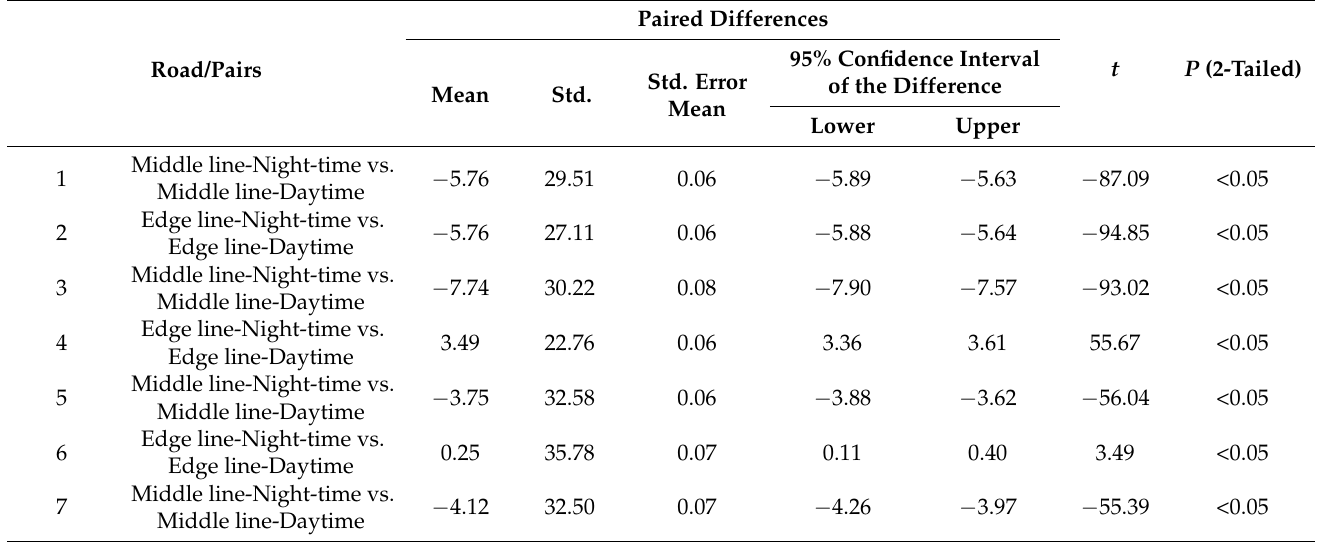
Table 7. Results of paired samples t